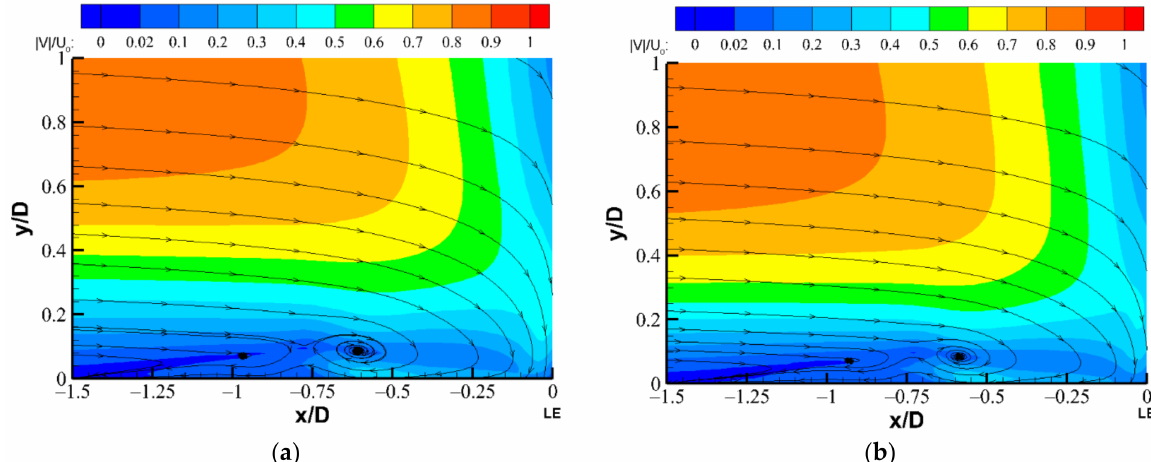
Figure 18. Ensemble-averaged velocity magnitude | V | at the z = 0 cm plane when ( a ) H / D = 0, and ( b ) H / D = 1.5.